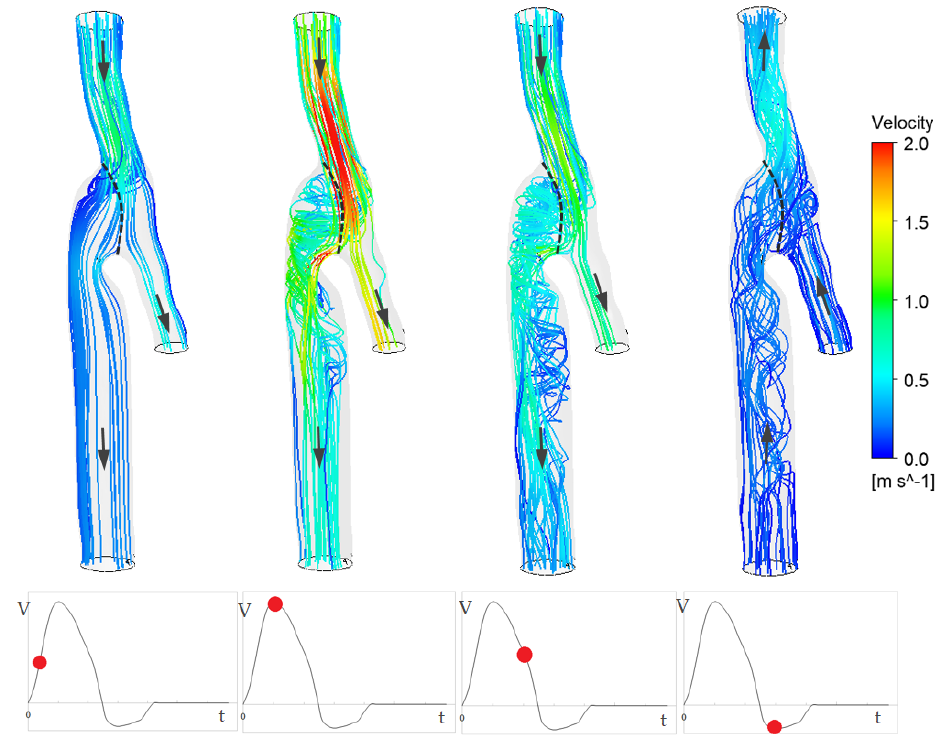
Figure 8. Streamlines at four time instances for the model 2 case: increasing, maximum, decreasing and reverse flow. Arrows indicate the blood flow direction.